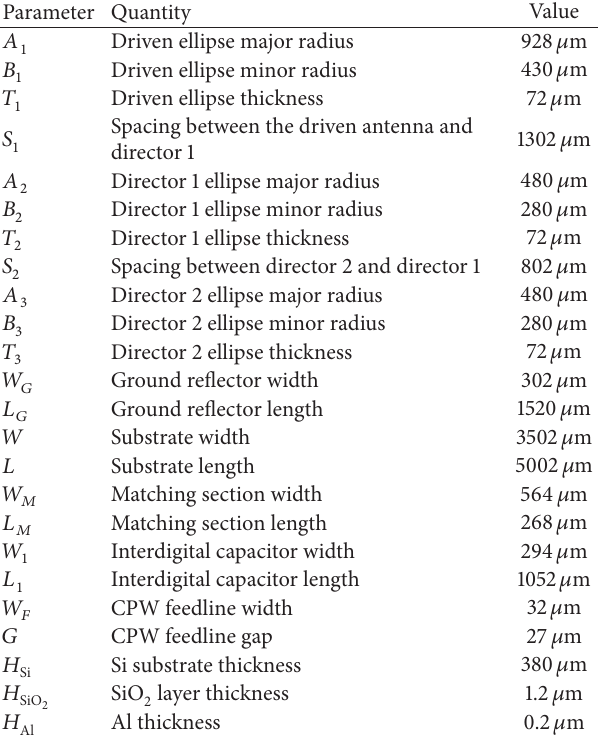
Table 1: Optimized Quasi-Yagi loop antenna prototype I dimen-